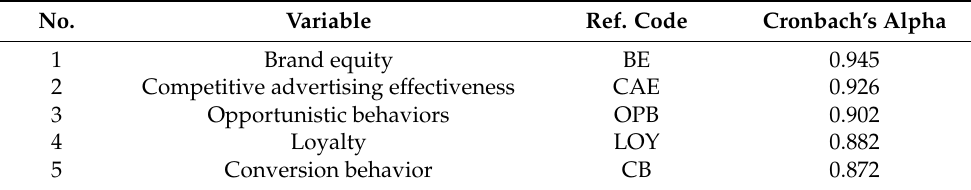
Table 2. Evaluation of the reliability of the scale through Cronbach’s Alpha’s coefficient.